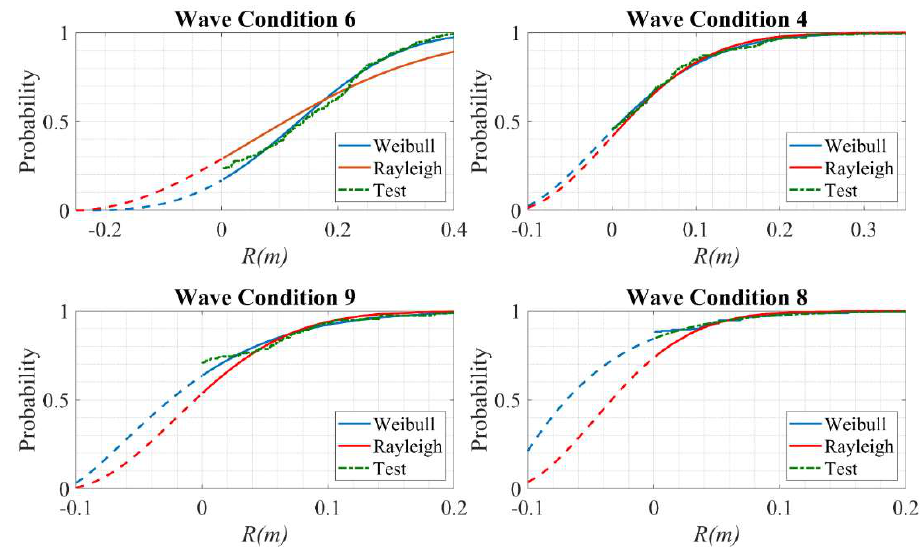
Figure 14. Representing peak value distribution of wave run-up with shifted Rayleigh and Weibull distribution, compared with test data.